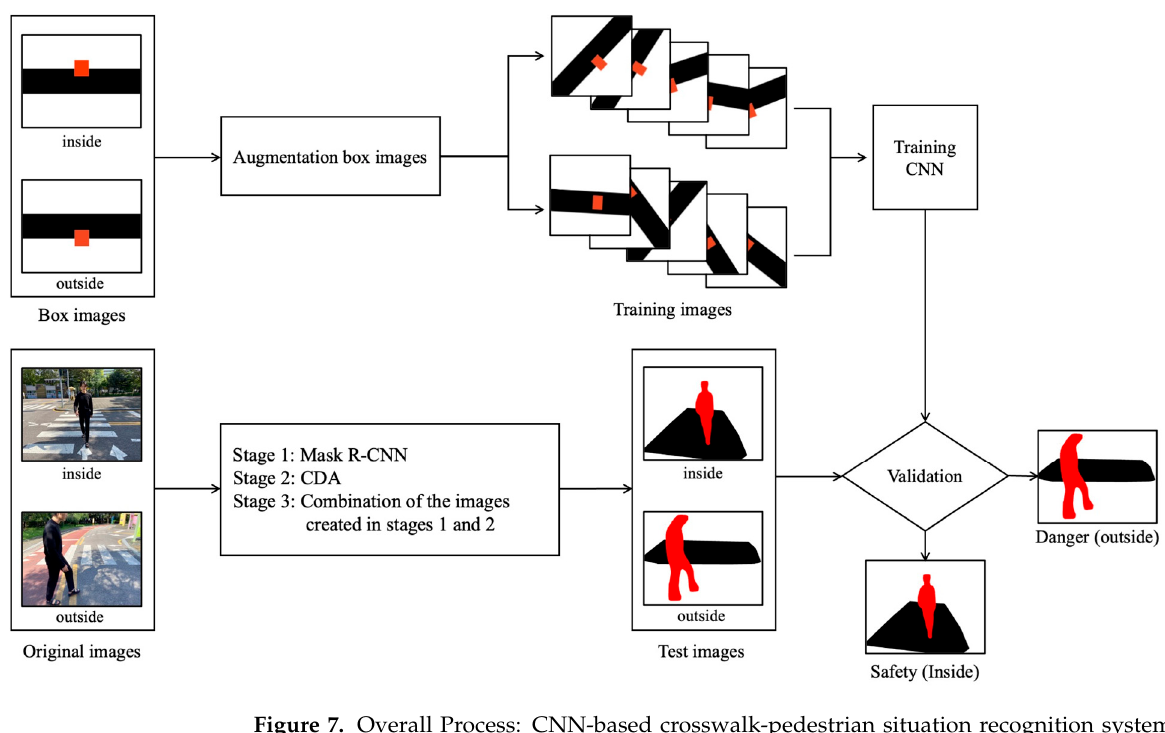
Figure 7. Overall Process: CNN-based crosswalk-pedestrian situation recognition system using box images.